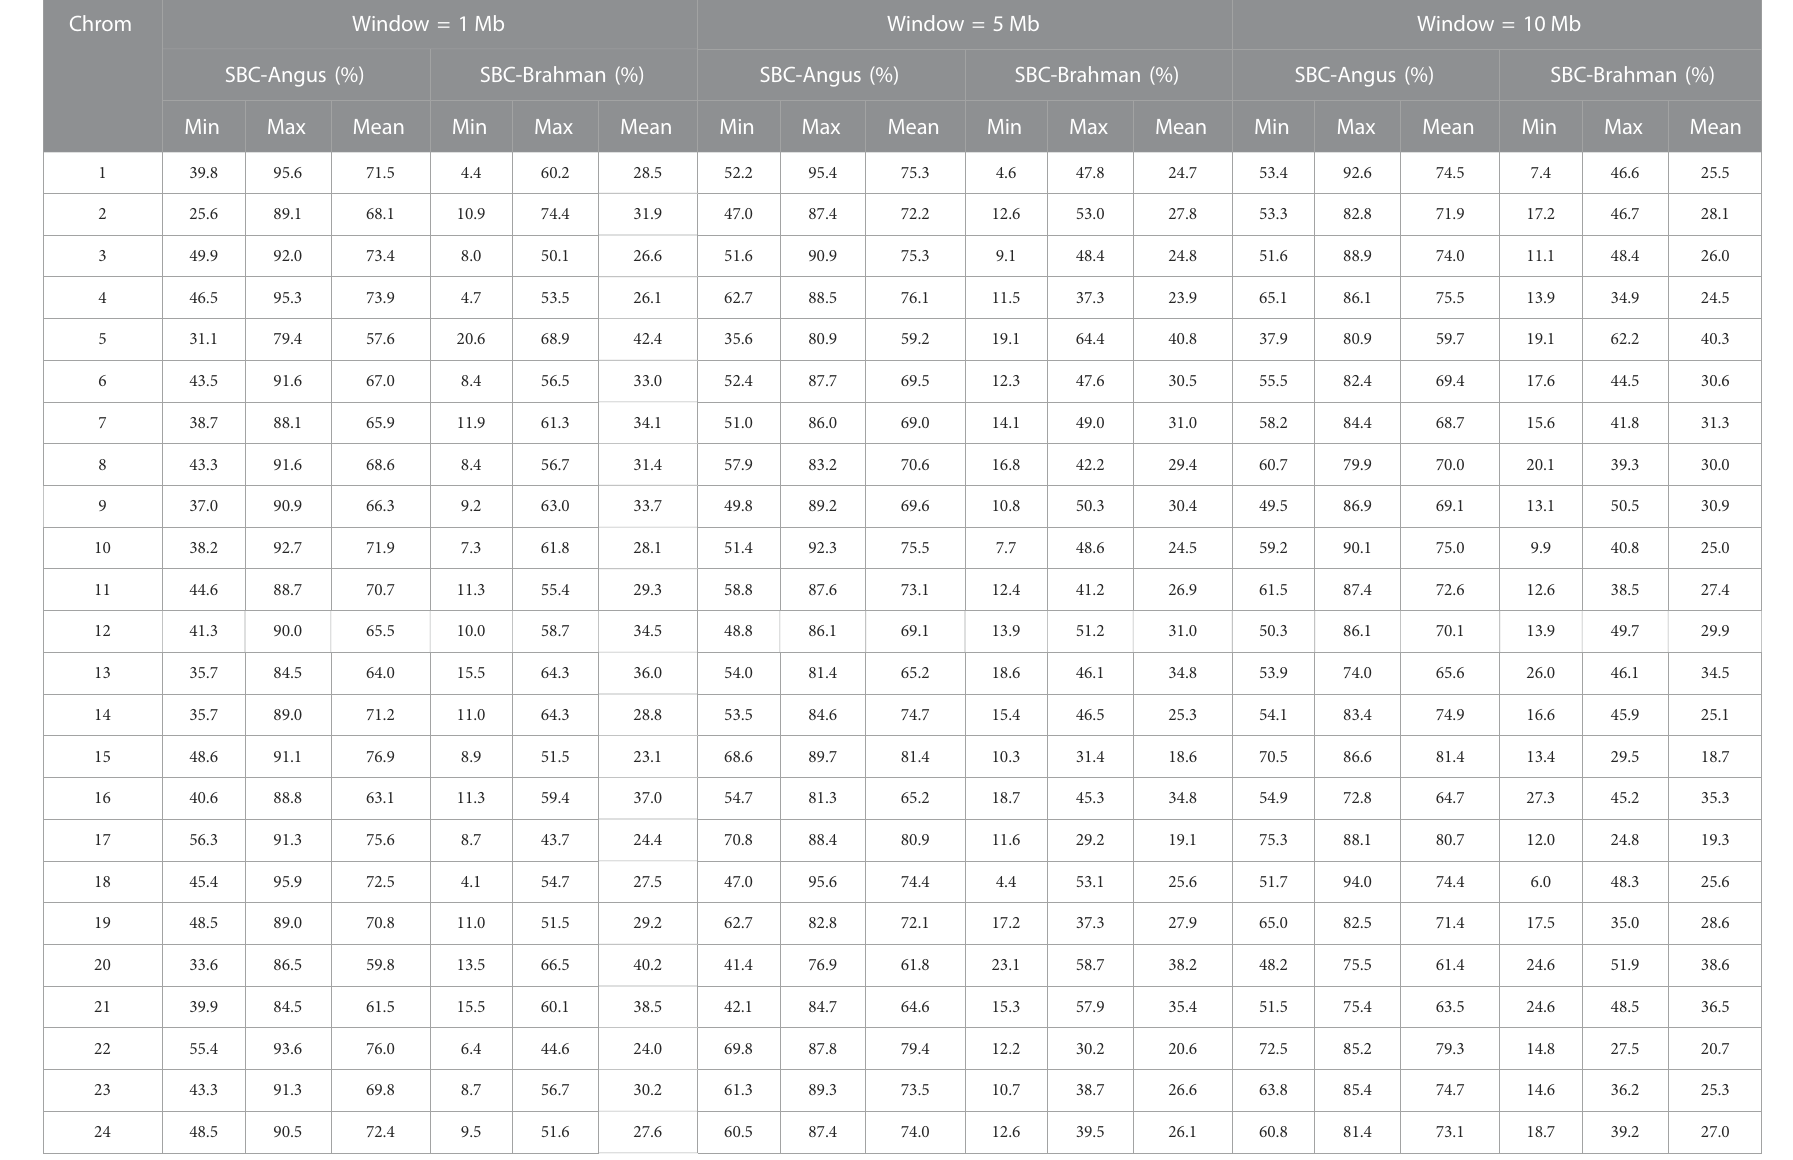
TABLE 5 Minimum (min), maximum (max), and mean of segmental-estimated breed compositions (SBC) per chromosome for Brangus.